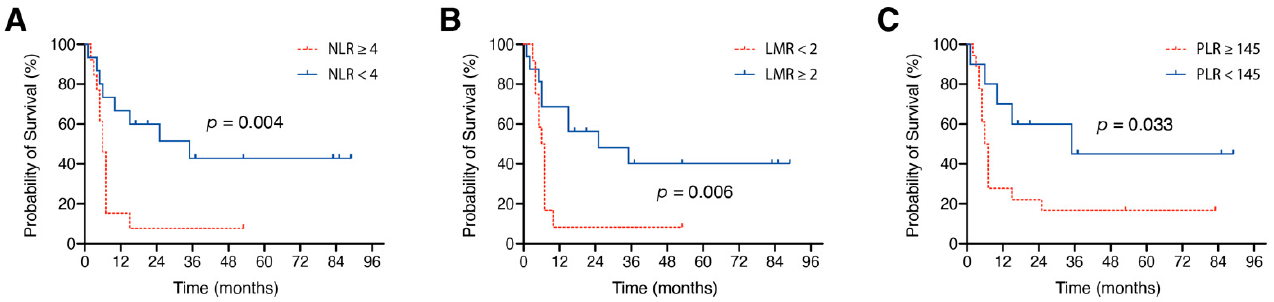
Figure 3. Kaplan–Meier curves for the association of ( A ) NLR, ( B ) LMR and ( C ) PLR and OS. LMR, lymphocyte-to-monocyte ratio; NLR, neutrophil-to-lymphocyte ratio; OS, overall survival; PLR, platelet-to-lymphocyte ratio.